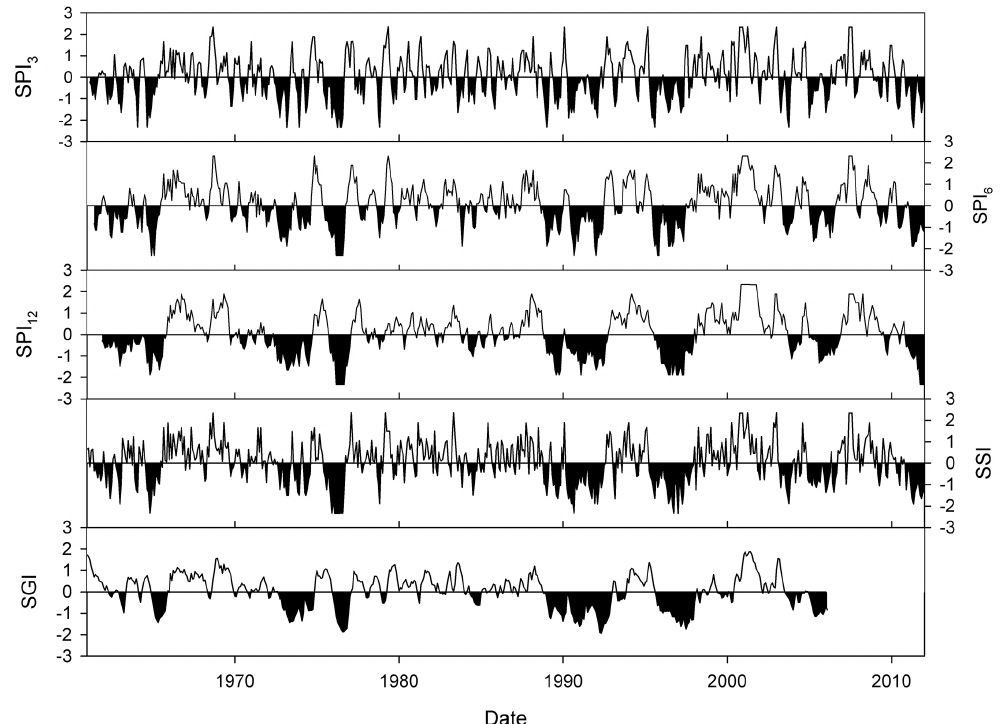
Figure 5. SPI, SSI and SGI for regional English Lowlands series, where the first three time series are SPI based on the English Lowlands precipitation time series, with SPI 3 month rainfall accumulation, SPI 6 month rainfall accumulation and SPI 12 month rainfall accumulation; the latter two are SSI for the English Lowlands regional river flow series and SGI for the English Lowlands groundwater level time